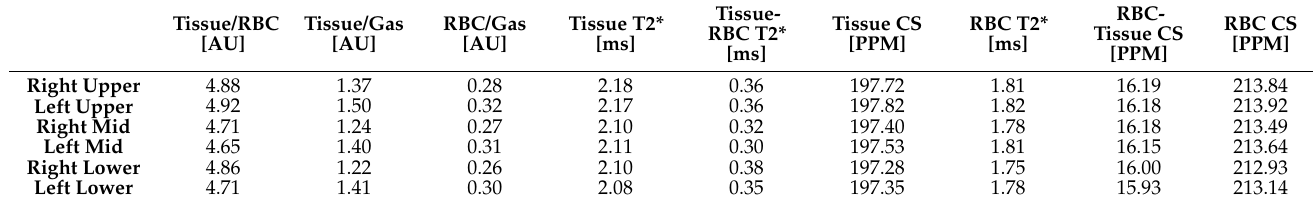
Table 4. 3D-SBCSI data by lung region for IPF subjects.